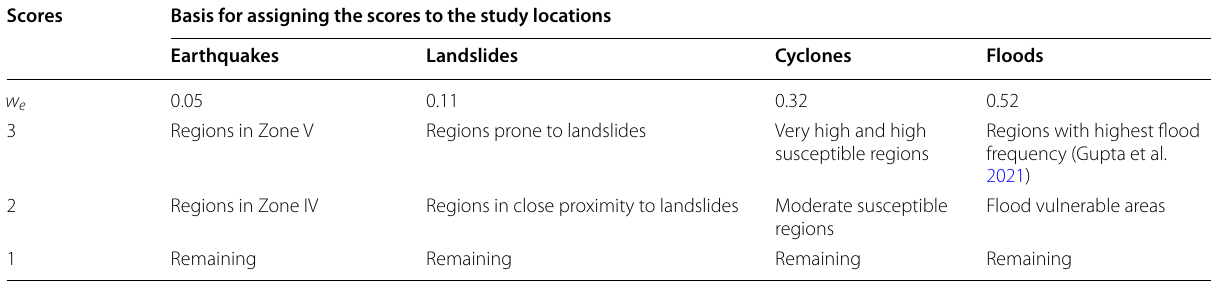
Table 4 Individual weights and the score assigning criteria for the environmental factors that affect the vulnerability of a VLBI station. For understanding the assigning criteria mentioned here, refer to Fig. 4 Scores Basis for assigning the scores to the study locations